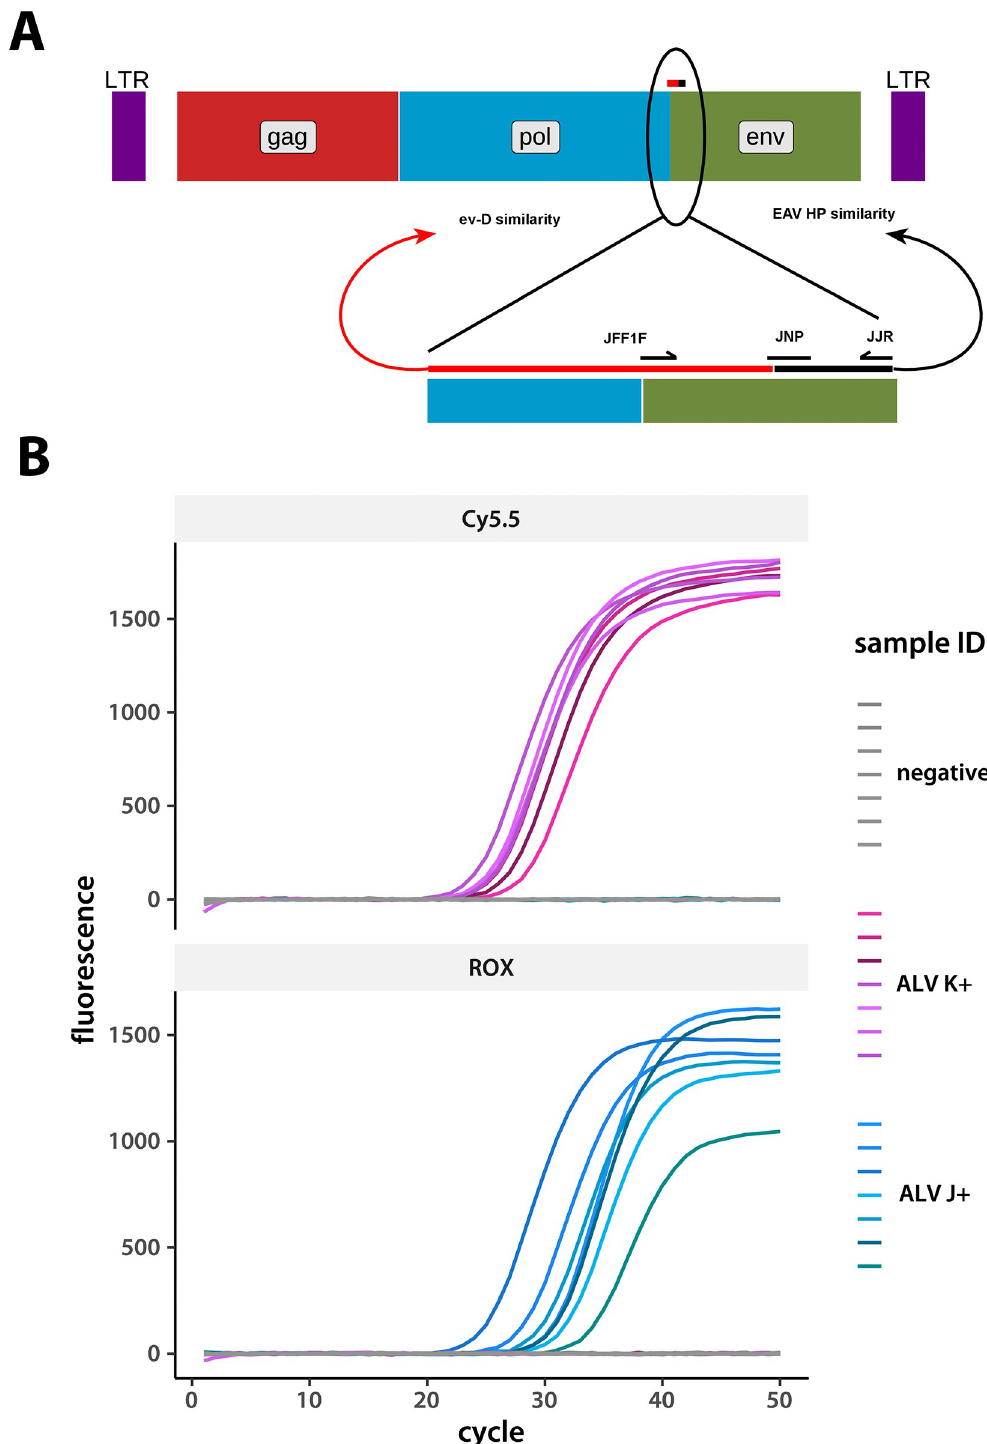
Fig 1. Specificity of the developed real-time PCR system for detecting ALV J and K. A . Primer positioning around the ev-D/EAV-HP (GenBank accession numbers DQ500016 and AC270426) similarity breakpoint in the ALV J gene that codes for the gp85 coat protein. A diagram of the full ALV genome is on top, with the region surrounding primer placement shown in detail below. B . A representative set of detection curves from the Cy5.5 and ROX channels (the KPL and JJPLN probes, respectively, in Table 1). Each curve is a sample from a separate bird. Eight ALV J positive, ALV K positive,